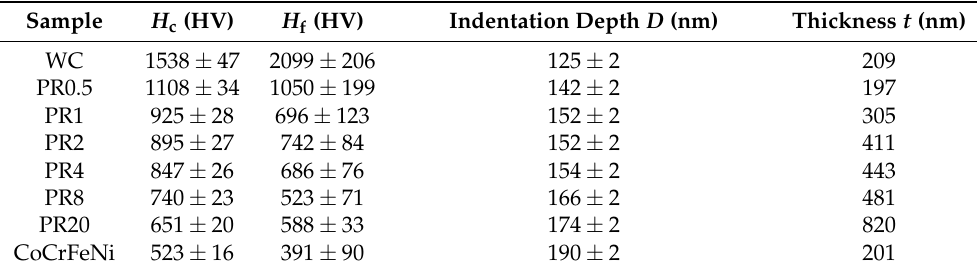
Table 2. Hardness values H c as measured via nanoindentation (black circles in Figure 4) and after the thin film correction from Jönnson and Hogmark [20] H f (empty circles in Figure 4). The indentation depth D and film thickness t necessary to calculate H f is given for the sake of